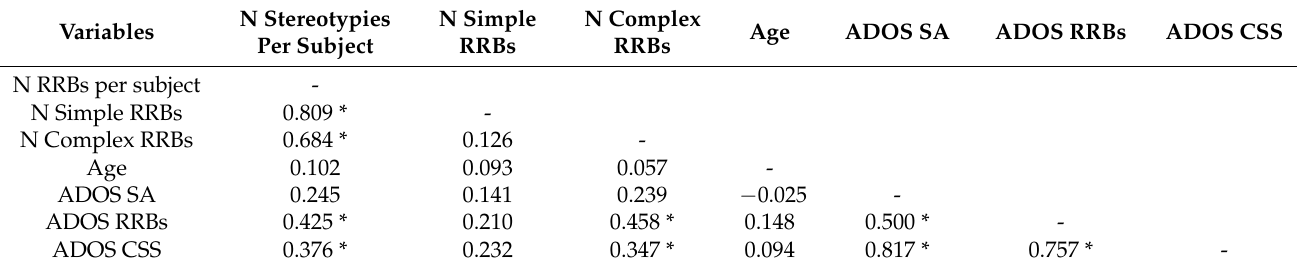
Table 6. Correlation tests among principal